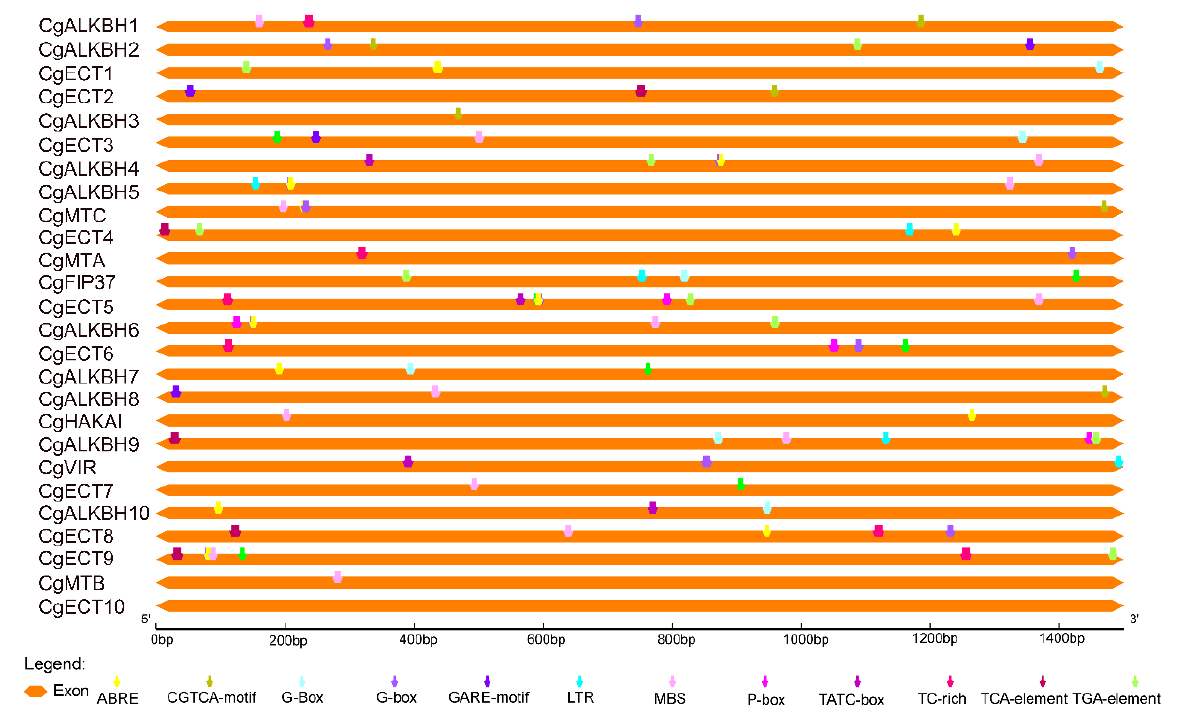
Figure 4. Cis -element analysis of 26 identified m 6 A regulatory genes in C. grandis from the upstream 1500 bp sequences to the transcription start site.